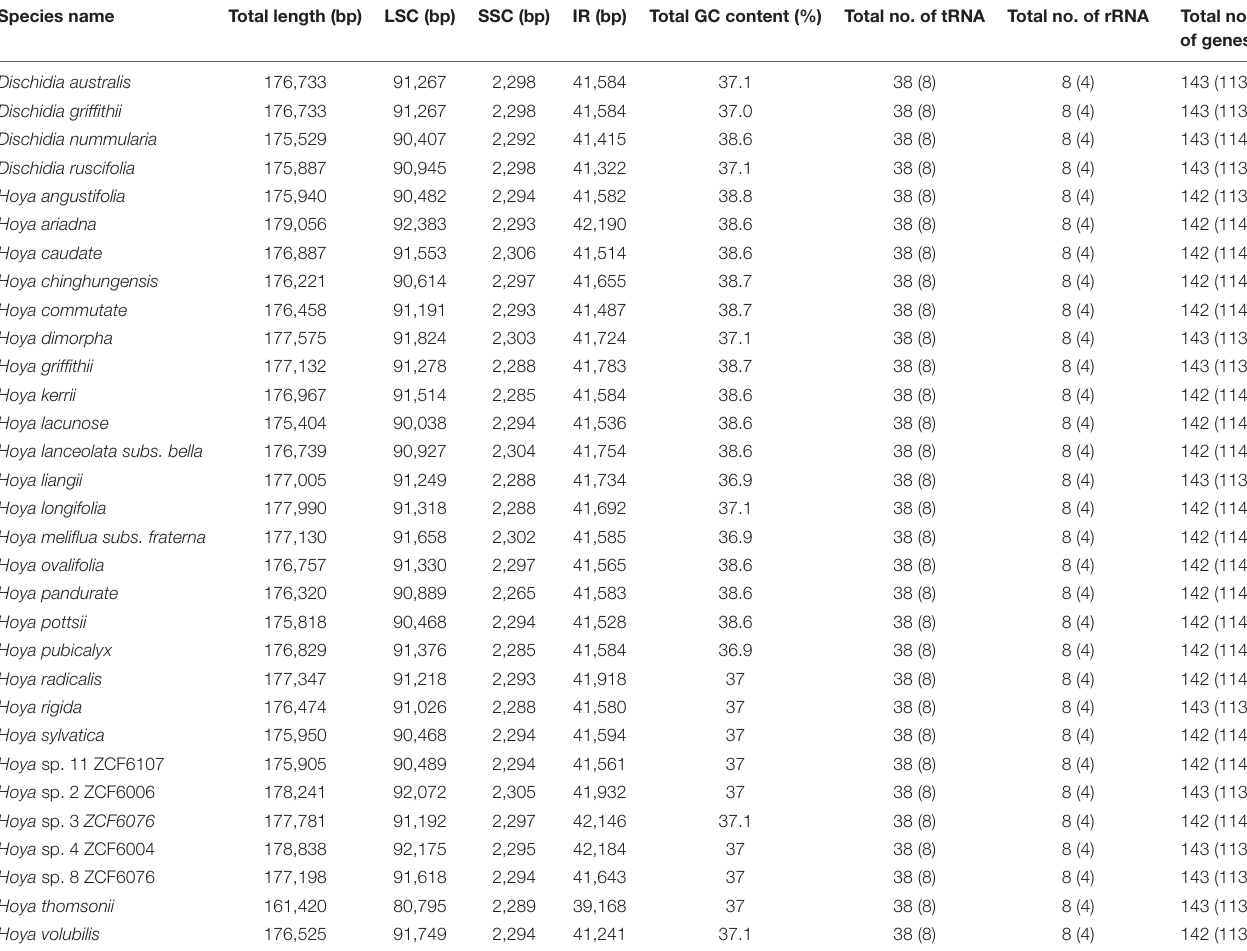
TABLE 1 | Summary of 31 Hoya plastome features that were assembled and annotated. Species